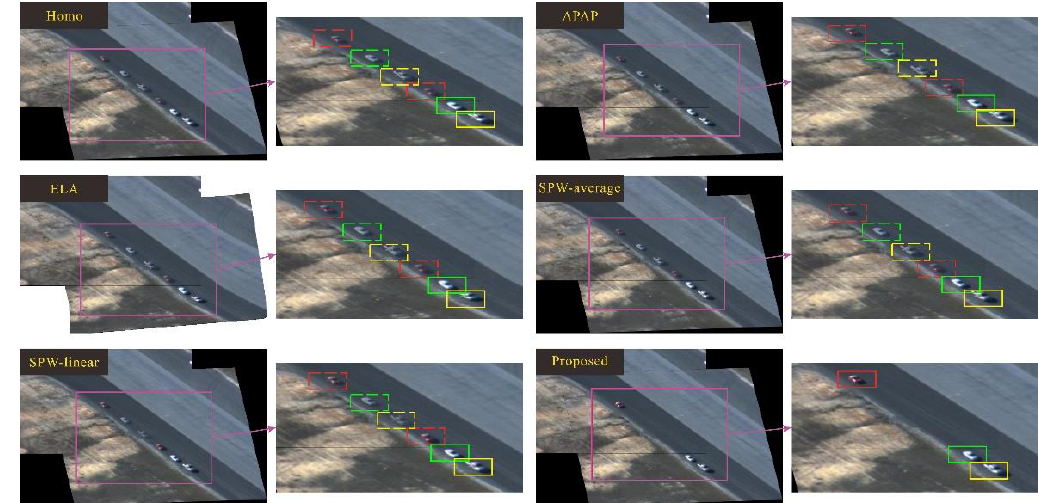
Figure 11. Comparison between the proposed method and SOTA methods on eg02 data.